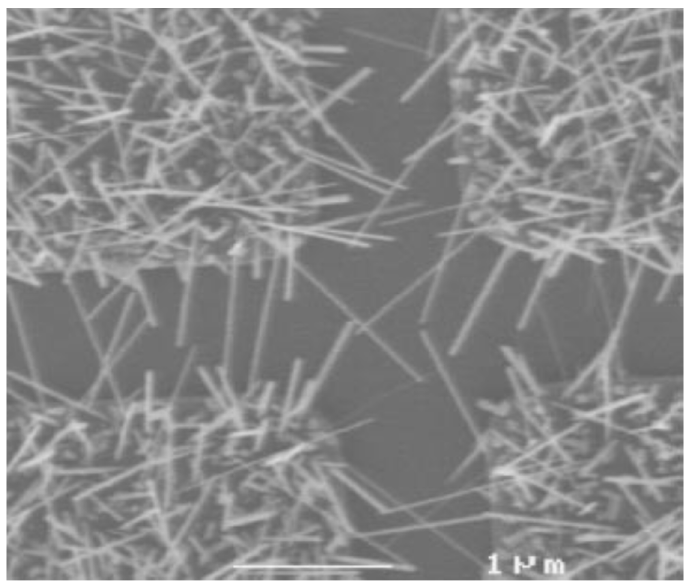
Figure 12. SEM image of IrO 2 nanowires obtained through MOCVD (Reprinted/adapted with permission from Ref. [110]).